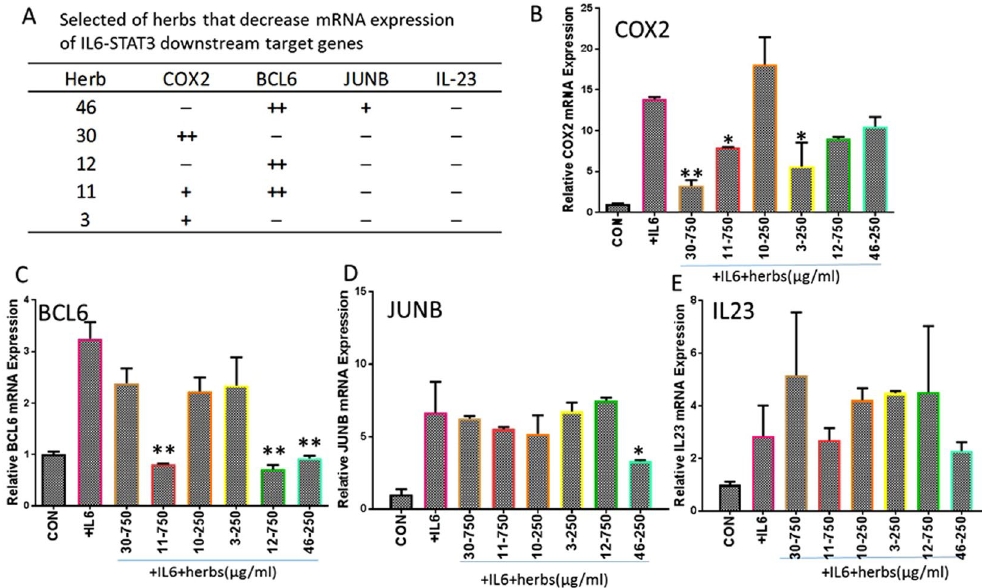
Figure 3. Impact of selected herbs on different IL-6-STAT3 downstream gene expression. ( A ) Table of herbs inhibited IL-6 induced mRNA expression of COX2, BCL6, JUNB and IL23. ( B – E ) Quantitative real time PCR for mRNA expression of STAT3 target gene COX2, BCL6, JUNB and IL23. Each bar represents a mean of three different experiments (triplicate samples of each). Compare with + IL-6 group, + , * p < 0.05; ++ , ** p < 0.01; − : no impact.